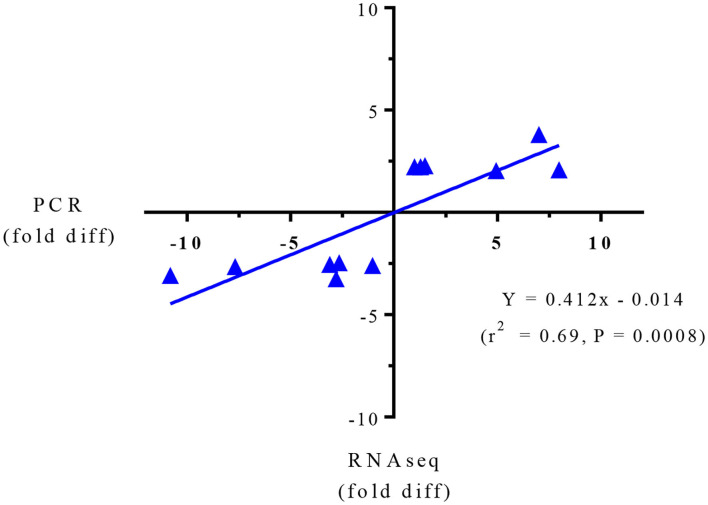
Regression analysis of RNAseq and PCR for targeted gene expression shown in Table 2.